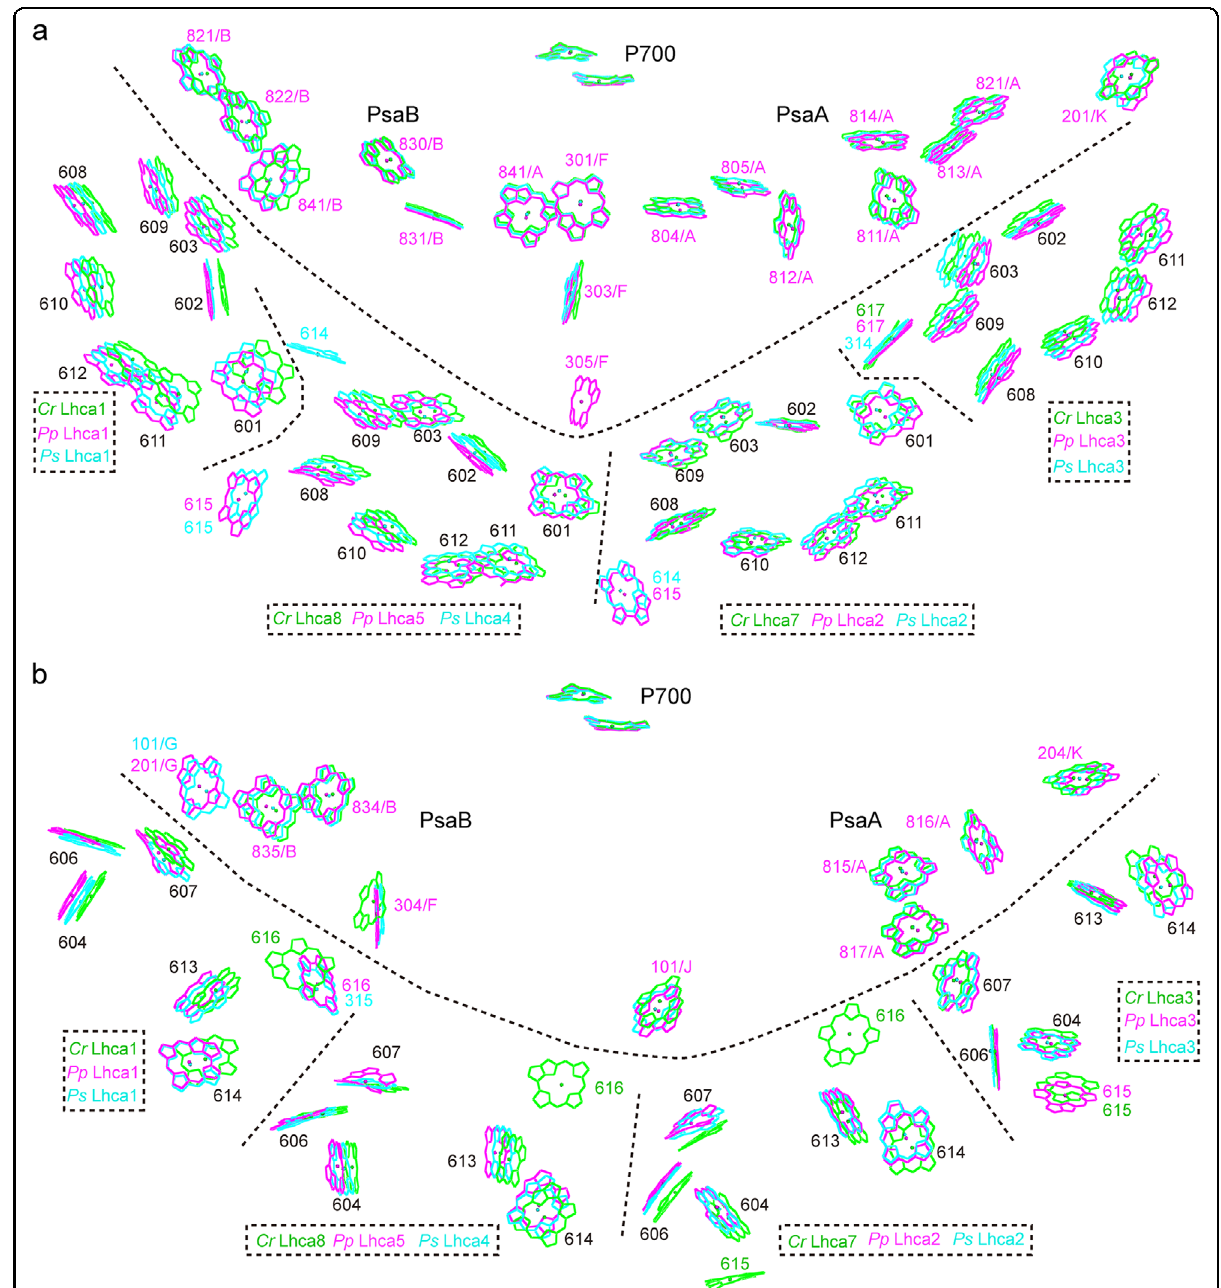
Fig. 4 Comparison of the Chl arrangement in LHCI from a moss P . patens , a green alga C . reinhardtii , and a lant plant P. sativum . Part of the core antenna Chls near LHCI and reaction center P700 were also shown. a Chl arrangement at the stromal layer. b Chl arrangement at the lumenal layer. Chls are labeled in the same color as the Lhca subunits they are associated with. Color codes and PDB ID codes: P . patens , violet, 6L35; C . reinhardtii , green, 6IJO; P . sativum , cyan,